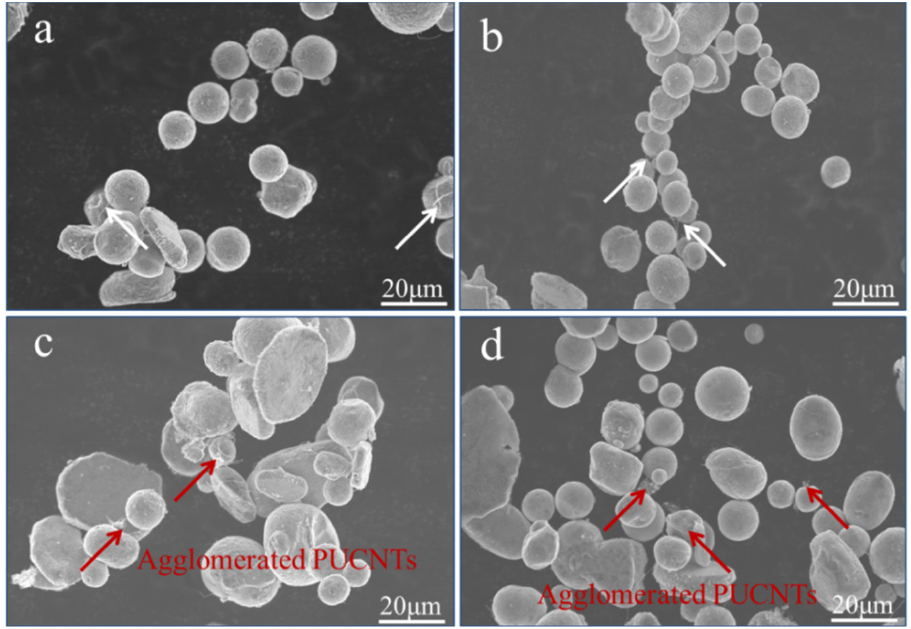
Figure 3. SEM morphology of ( a ) 0.1 PUCNTs/Zn, ( b ) 0.2 PUCNTs/Zn, ( c ) 0.3 PUCNTs/Zn, and ( d ) 0.5 PUCNTs/Zn powders.